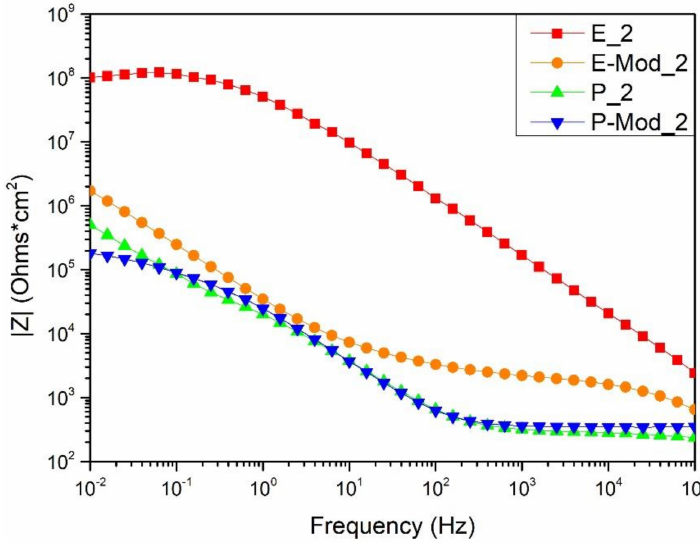
Figure 7. Bode impedance modulus of samples related to environment